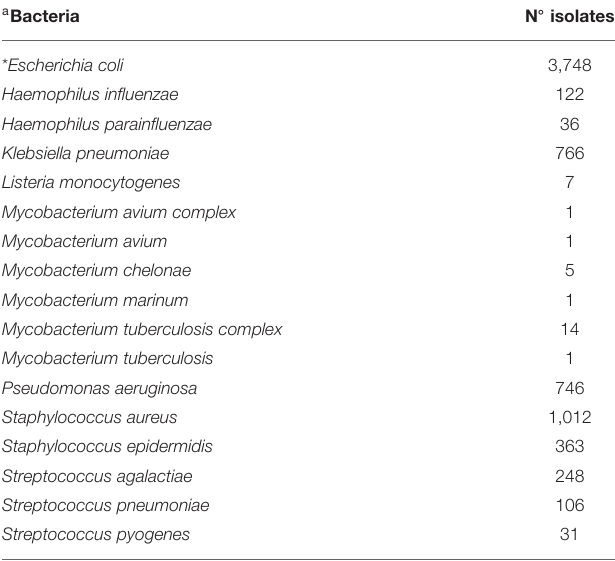
FIGURE 2 | correspond to Coomasie stained gels of purification of His-recombinant proteins (lower left) and DC uptake of prepared mRNA from all antigens (PLY of SP, Ag85A of MM, LLO, or GAPDH of LM) conjugated to the lipid carrier, lipofectamine, and after 16h DC cells are lysed. Lysates were immunoprecipitated with rabbit anti-LLO antibody (DIATEVA), rabbit anti-Mycobacterium antibody (Colorado University), rabbit anti-PLY (a gift from JR de los Toyos, Oviedo, Spain), and rabbit anti-LM-GAPDH1-22 antibody (C. A-D and M.F obtained at CBMSO) (24). All immunoprecitpates were stained with Coomasie blue. (B) DC apoptosis (light gray bars) and DTH responses measured as the footpad swelling (dark gray bars) evaluated after incubation of DC with different antigens: empty DC (DC-CONT), lipofectamine (DC-LIPO), recombinant proteins as PLYrec from SP, LLOrec, and GAPDHrec from LM and antigen Ag85A from MM or mRNA-LIPO complexes of PLY, LLO, GAPDH, or Ag85A. Apoptosis is measured in vitro by flow cytometry and results are expressed as the percentages of annexin-V positive cells ± SD of three different experiments. ANOVA test was applied for flow cytometry results ( P ≤ 0.05). DTH responses are measured in vivo after inoculation of right hind footpads of C57BL/6 mice with the different DC vaccines ( n = 5 per DC vaccine). Forty-eight hours after inoculation of DC vaccines, DTH responses are evaluated by the swelling of the hind footpads measured with a caliper. Results are expressed as millimeters ± SD of each group of 5 mice. Student t -Test was applied for statistical analysis ( P ≤ 0.05). (C) C57BL/6 mice were immunized i.v with 5 × 10 3 CFU/mice (HUMV-LM01, HUMV-MM01, or HUMV-SP01) and 7 days later, left hind footpads were inoculated with 1 × 10 6 DC vaccines (pre-loaded with 5 µ g/mL of LLOrec, GAPDHrec, or 50 g/mL of mRNA-LIPO-GAPDH or mRNA-LIPO-LLO, or 1 × 10 6 CFU of LM, MM or SP, LIPO incubated DC, or saline incubated DC). Popliteal lymph nodes are isolated from mice legs and after homogenization, T cells sub-populations are analyzed by flow cytometry. Percentages of CD4 + (green bars) or CD8 + T cells (red bars) are shown. Results are expressed as the percentages of positive cells ± SD of three different experiments. Student t -Test was applied for statistical analysis ( P < 0.05).